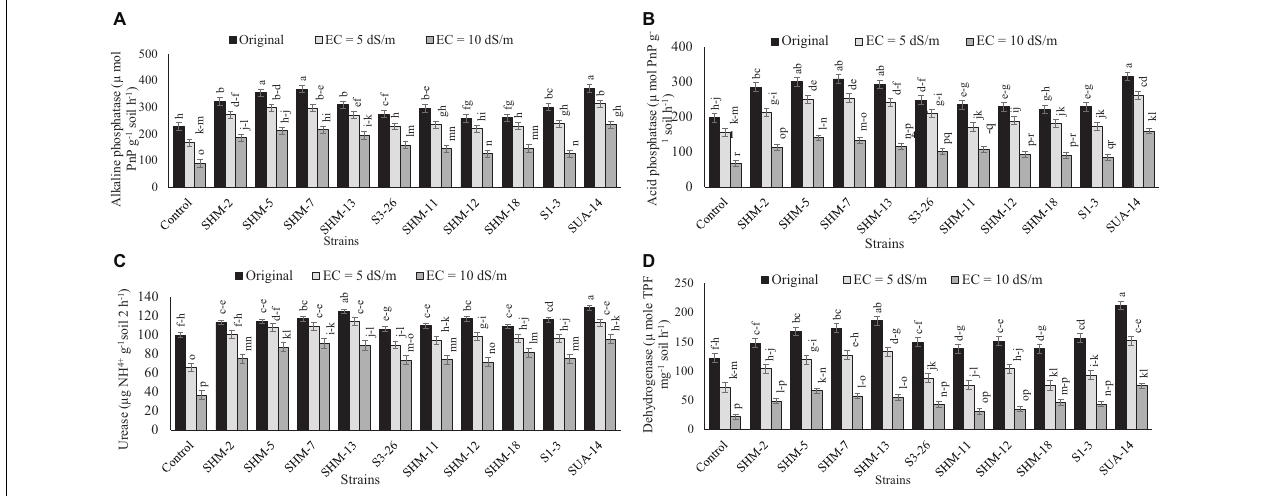
FIGURE 5 | Effect of rhizobacterial inoculation on the soil enzyme activities, i.e., (A) alkaline phosphatase ( µ mol PnP g − 1 soil h − 1 ), (B) acid phosphatase ( µ mol PnP g − 1 soil h − 1 ), (C) urease ( µ g NH 4 + g − 1 soil 2 h − 1 ), and (D) dehydrogenase ( µ mole TPF mg − 1 soil h − 1 ) under salt-stressed pot conditions. Bars sharing the same letters are statistically non-significant at p ≤